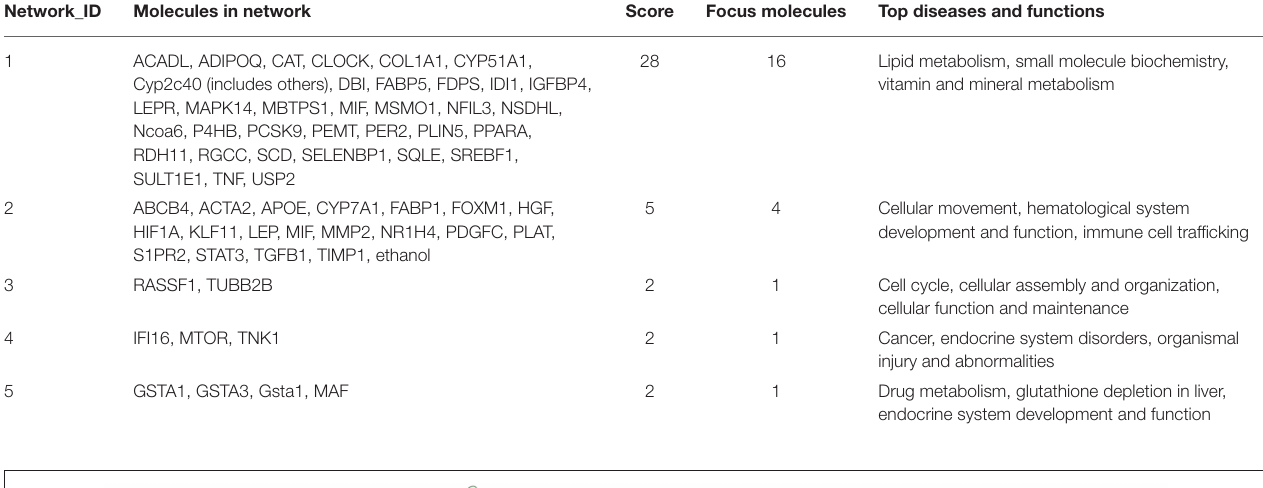
TABLE 10 | Molecular networks between Phb1 + / − and WT. Network_ID Molecules in network Score Focus molecules Top diseases and functions